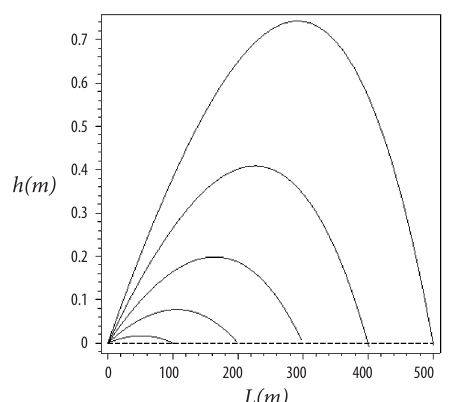
Fig. 2. AK74 bullet paths. The aiming line is reflected in hyphens